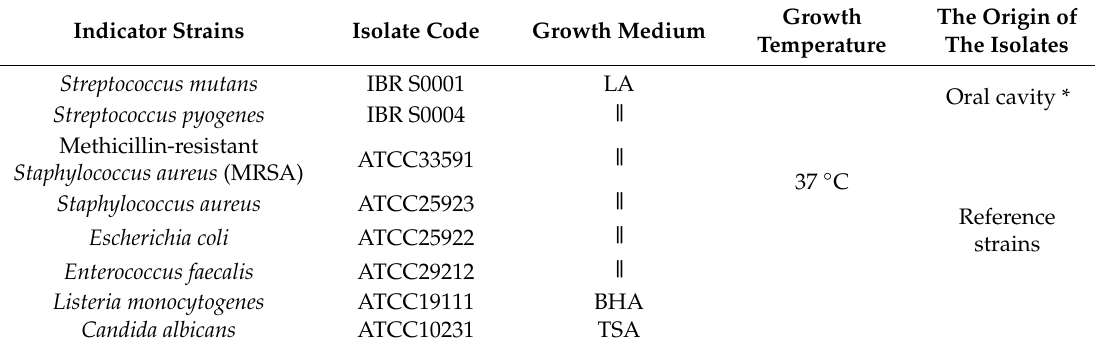
Table 2. Indicator strains used in testing antimicrobial activity of selected extracts from forest